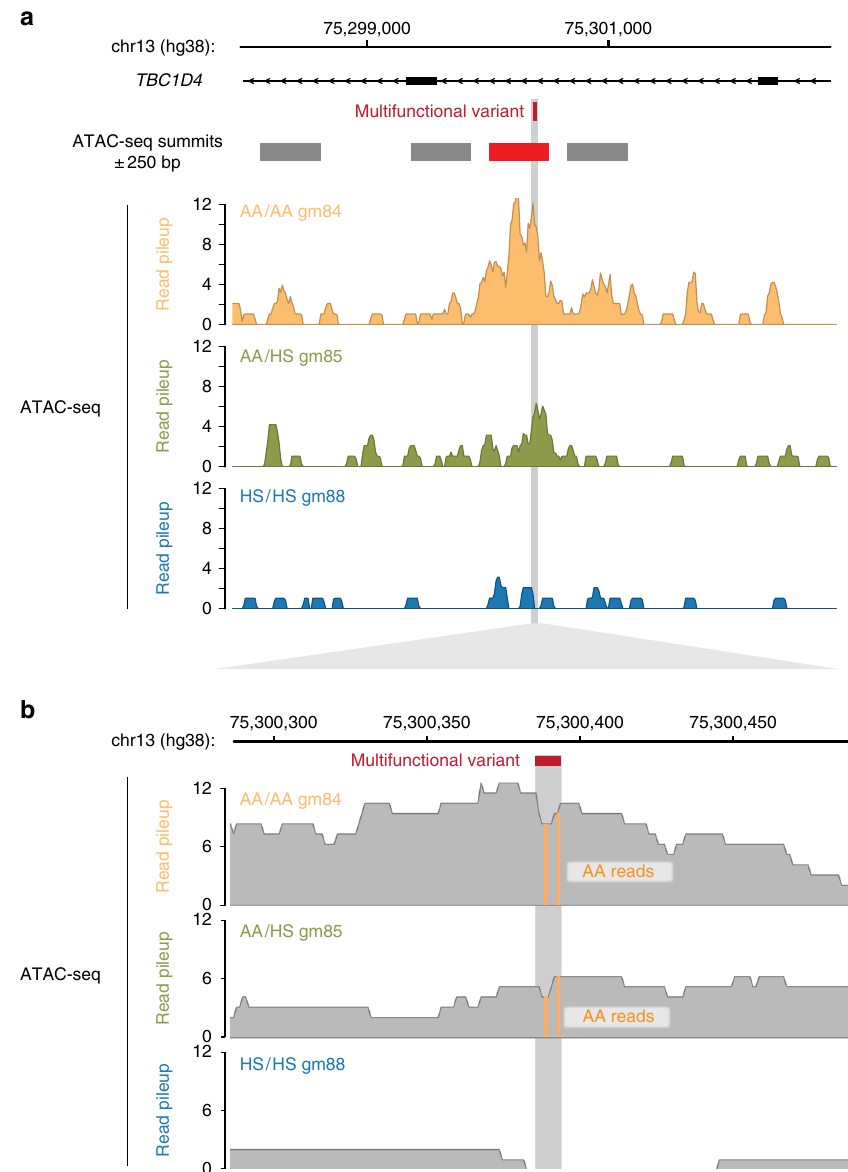
Fig. 6 Allelic chromatin accessibility at the TBC1D4 multifunctional variant. The TBC1D4 multifunctional variant is associated with open chromatin present on the ancestral allele (AA) but not on the human-speci fi c (HS) allele. In a we show the 5 kb region fl anking the local ATAC-seq peaks, with the peak (summit ± 250 bp) re fl ecting the caQTL shown in red. In b we represent polymorphic AA sequences where C>T transitions are present with orange, showing that in the heterozygous GM(128)85 cell line, all of the reads are from the AA, and none from the HS allele in the same